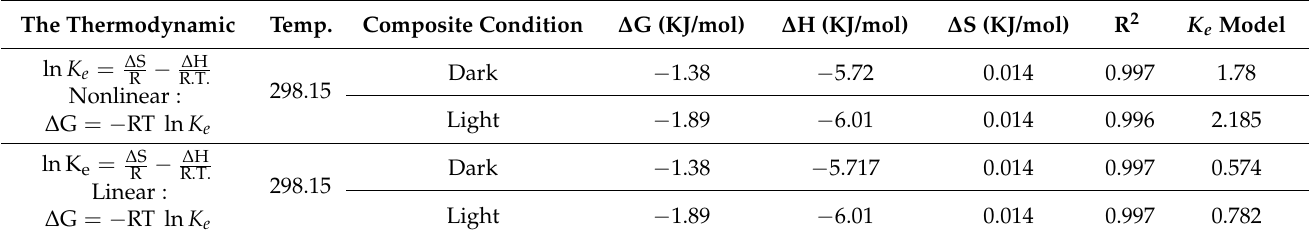
Table 4. The Thermodynamic model.